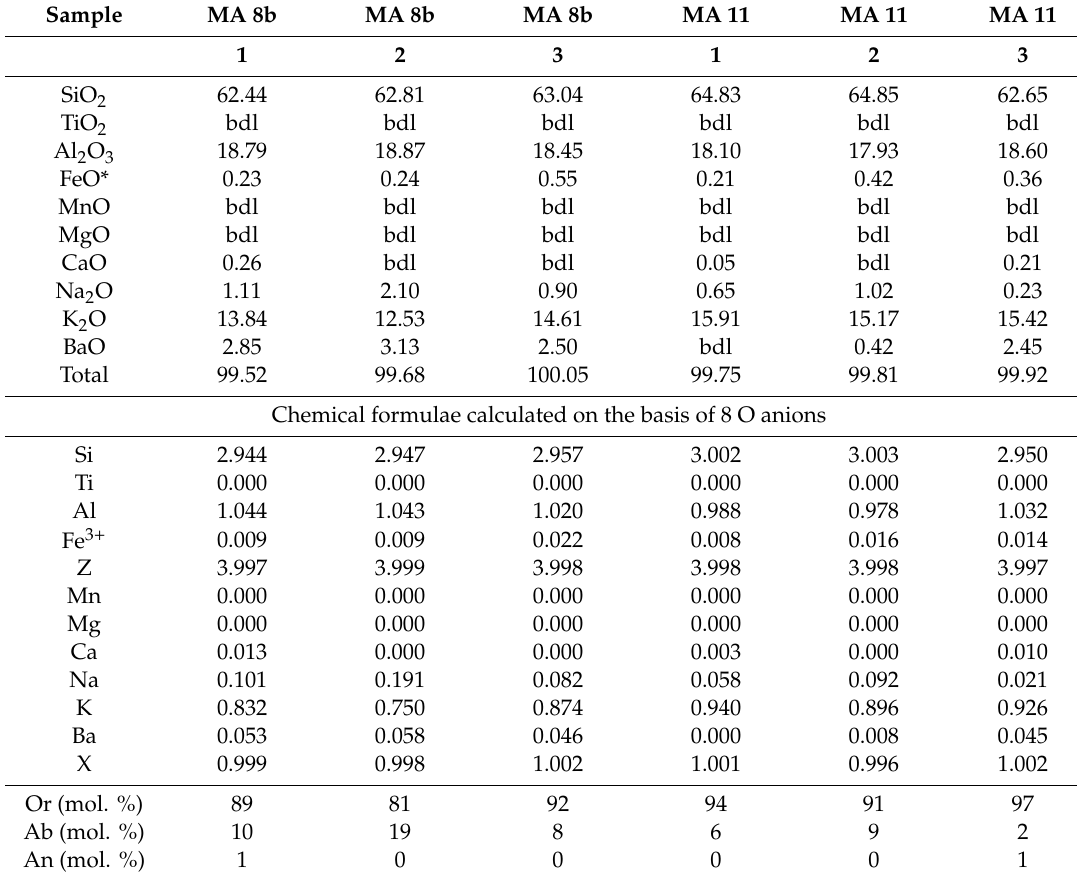
Table 3. Representative microanalyses (wt. %) and calculated formulae of hydrothermal K-feldspar in potassic alteration zone in the Maronia deposit. FeO*: total iron as FeO; bdl: below detection limit.